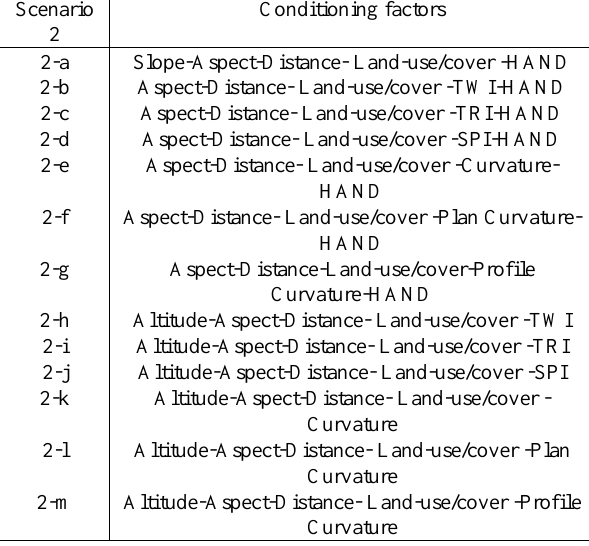
Table 2. Combinations of different conditioning factors for implementations in Scenario 2